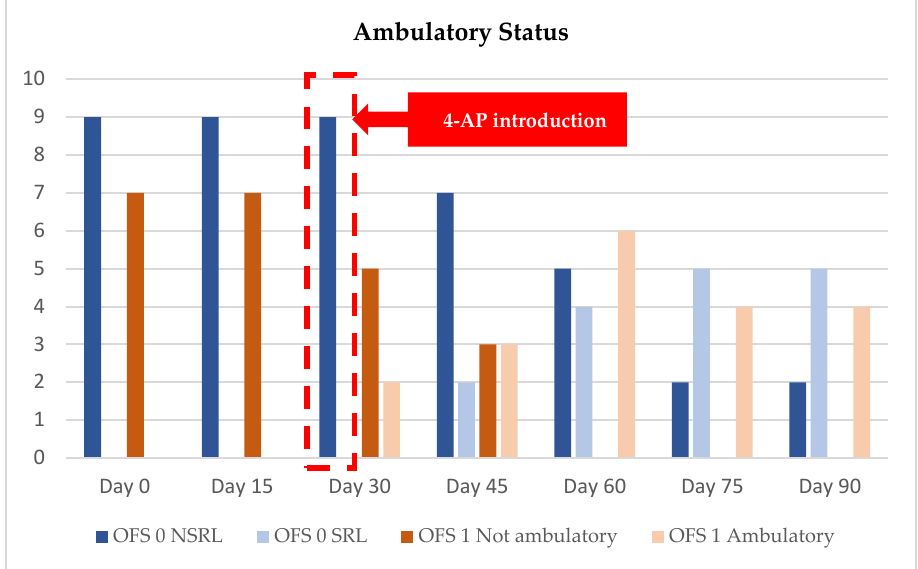
Figure 5. Evolution of ambulatory status and medical discharge from admission (day 0) until day 90. OFS—open field score [64]; SRL—Spinal Reflex Locomotion; NSRL—Non-Spinal Reflex Locomotion; OFS 0: blue color; OFS 1: brown color.